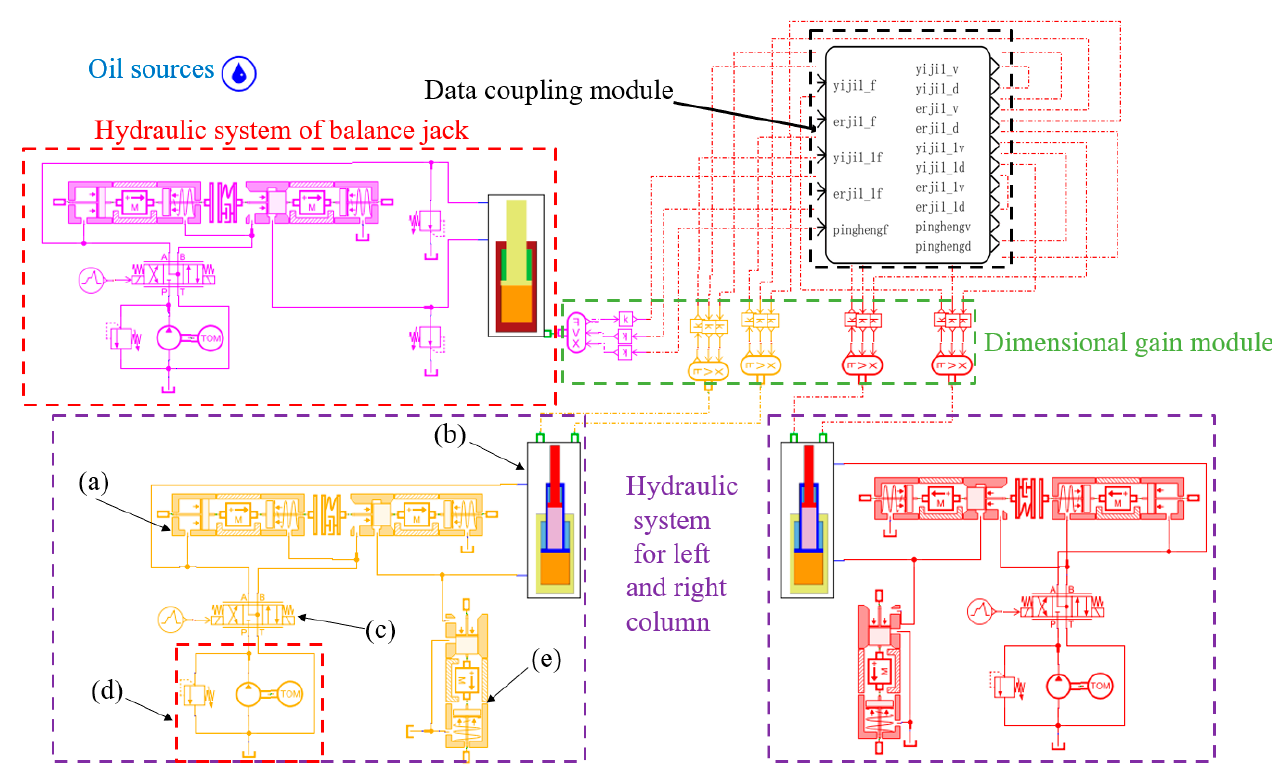
Figure 2. Hydraulic circuit diagram.